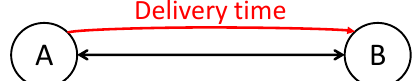
Figure 4. Single-hop delivery time evaluation (Table 1).